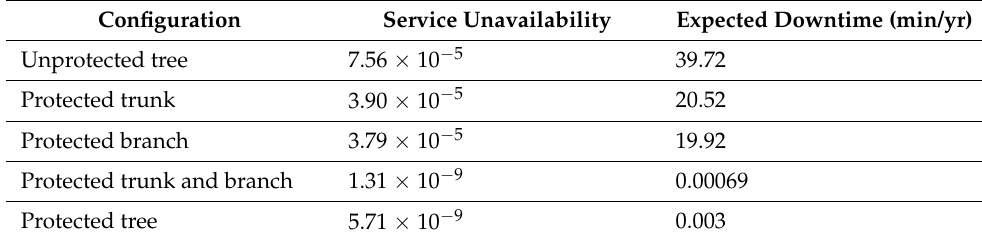
Table 1. Unavailability and expected downtime of FTTH PON